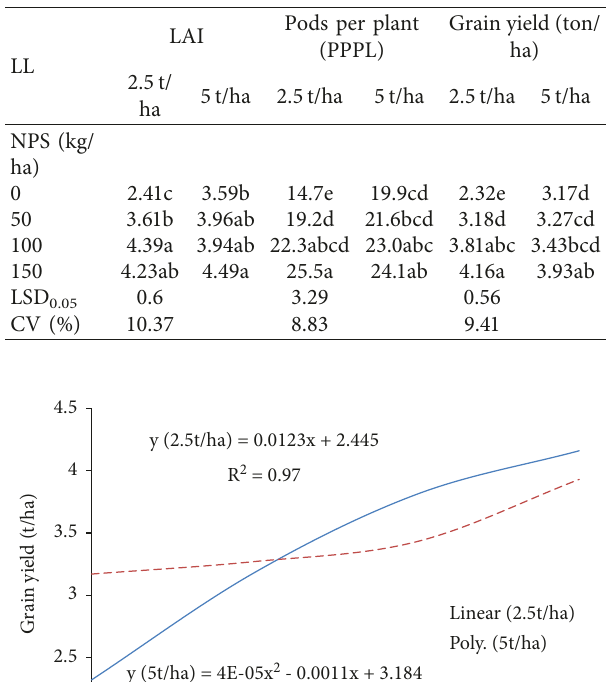
Table 5: LAI, pods per plant, and grain yield of common bean affected by LL and NPS